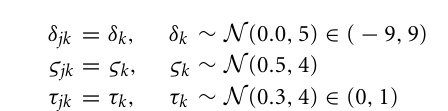
FIGURE 4 | A graphical representation of Model 1 (A) and Model 2 (B). In Model 1 , drift rates δ k , diffusion coefficients ς k , and non-decision times τ k were assumed to vary over conditions k but remain invariant across participants j and trials i . There were three bar rotation conditions and three contrast noise conditions. Here k denotes each bar rotation and contrast